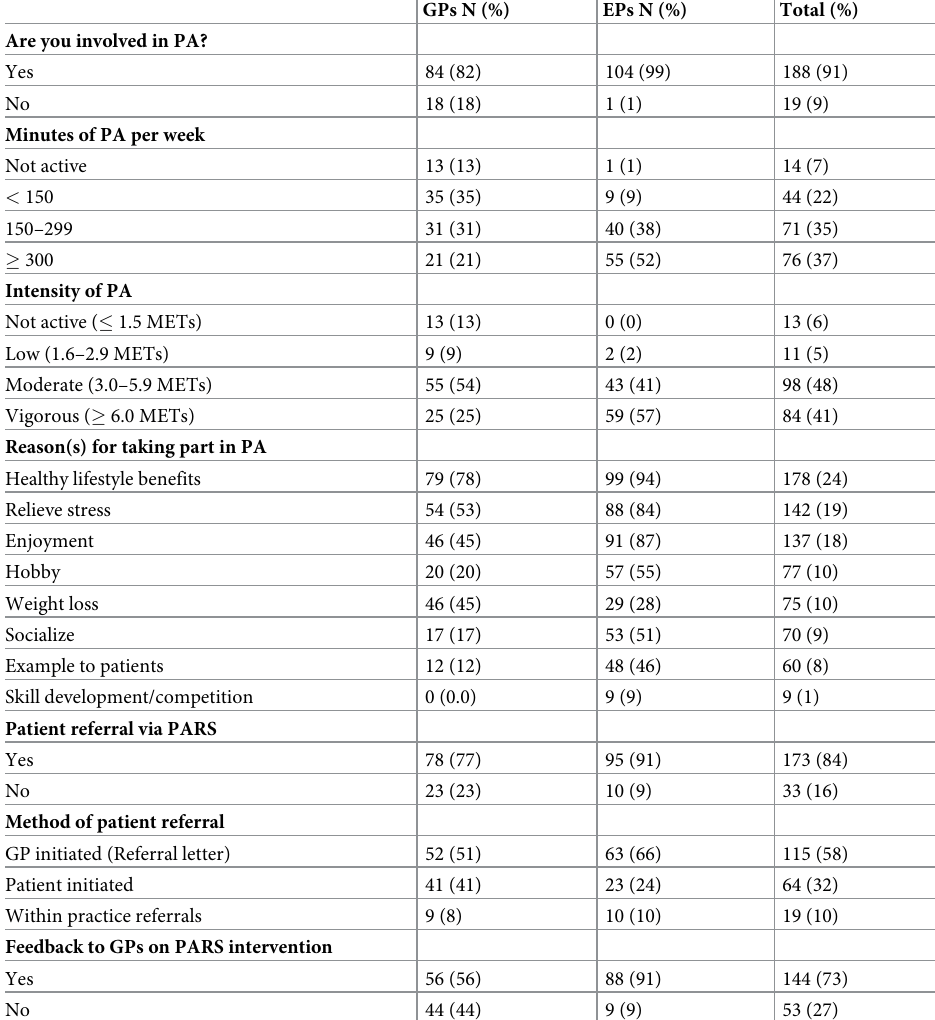
Table 2. Participants’ PA/PARS attitudes (N =